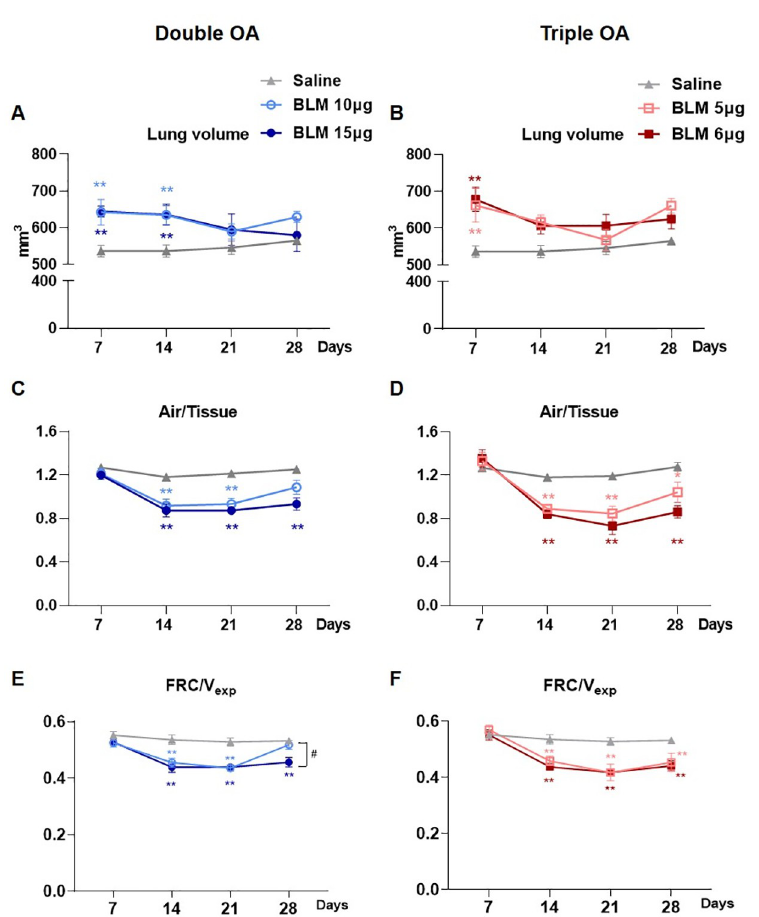
Fig 3. Longitudinal lung function readouts. Longitudinal analyses of the lung volume detected by micro-CT in mice treated with double (A) or triple (B) doses of BLM, compared with the saline group. Longitudinal quantification of air/ tissue ratio in double (C) or triple (D) doses of BLM. Longitudinal quantification of FRC/V exp in double (E) or triple (F) doses of BLM. Data are shown as mean ± SEM. The statistical differences were calculated by two-way ANOVA followed by Tukey’s test ( � p < 0.05; �� p < 0.01 vs. saline group. ## p < 0.01 comparing 10 μ g vs. 15 μ g BLM). N = 5 per